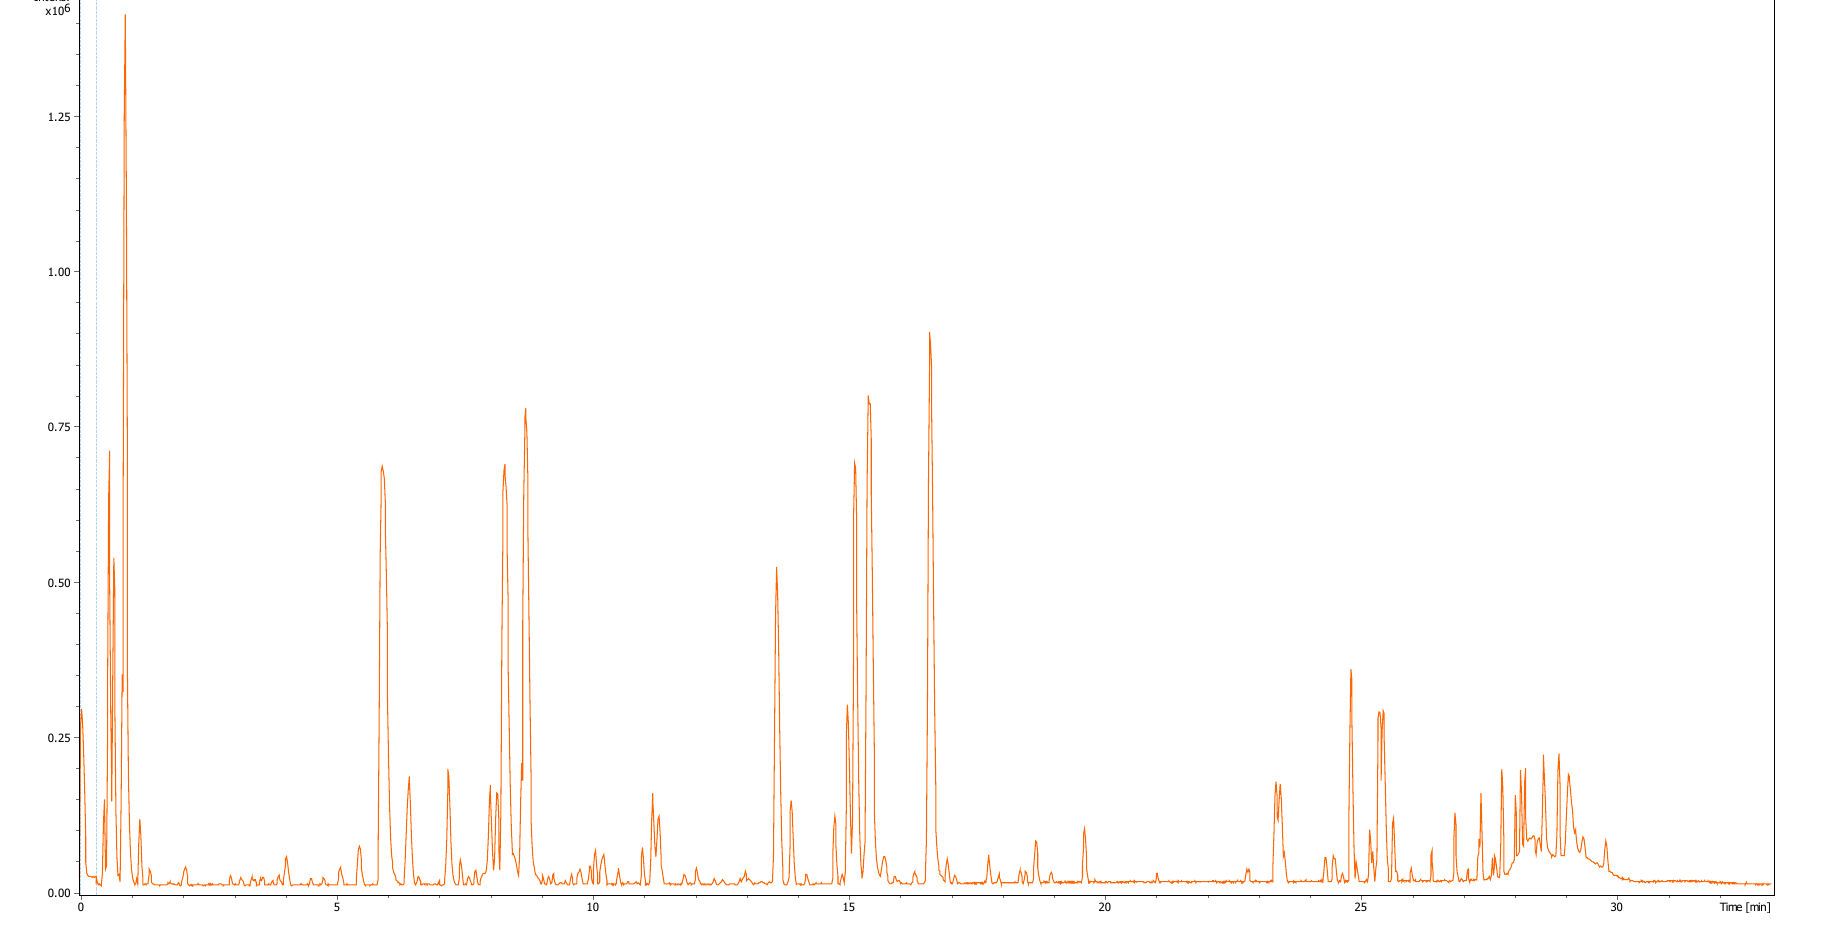
Figure A2. Ilex paraguariensis A.St.-Hil. leaves water extract, basic peak chromatogram, negative mode.